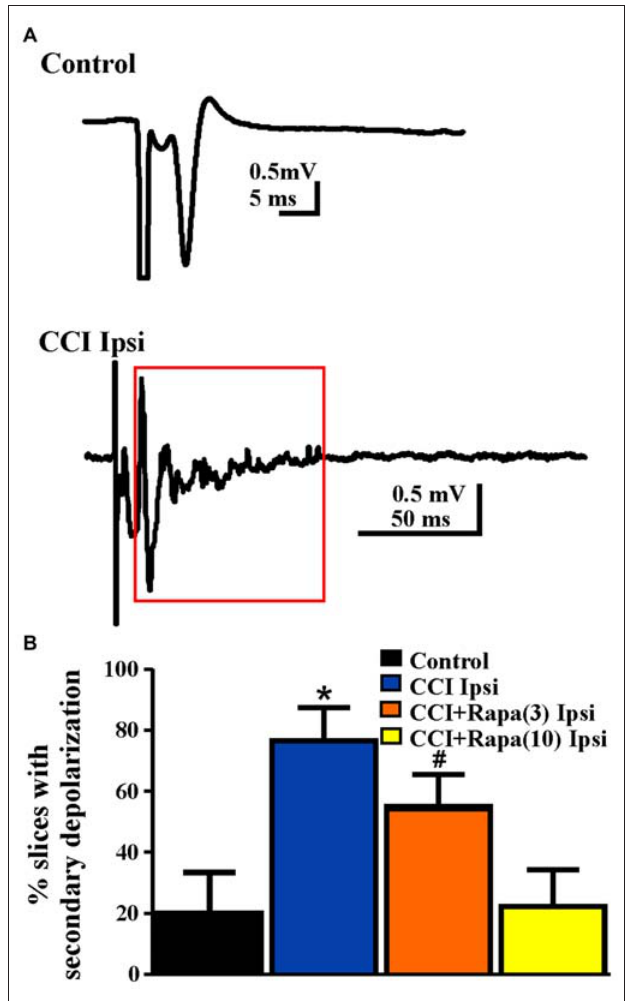
FIGURE 5 | Network excitability of dentate granule cells after antidromic electrical stimulation 8–13 weeks post-injury. (A) Representative traces of field potential responses to antidromic hilar stimulation in control and CCI-injured mice. A secondary depolarization was often observed in slices ipsilateral to CCI injury (red box indicates area of secondary depolarization). (B) Percentage of slices ipsilateral to injury that displayed secondary depolarization from control, CCI Ipsi, CCI + Rapa(3) Ipsi, and CCI + Rapa(10) Ipsi treatment groups. Error bars represent SEM; ∗ p < 0.05 for CCI Ipsi relative to control or CCI + Rapa(10). # Indicates p < 0.05 for CCI + Rapa(3) Ipsi vs.